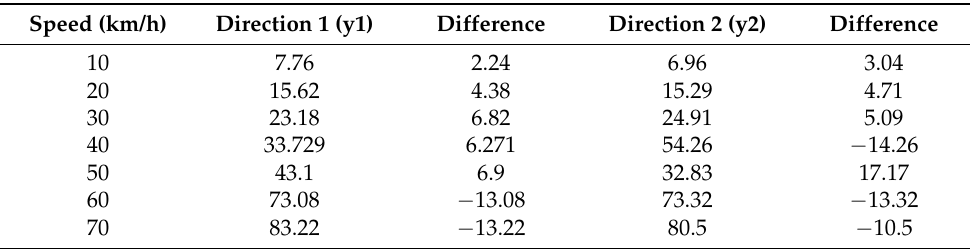
Table 6. The real car speed and detected speed with the proposed system over different car directions (Direction 1: near side and Direction 2: faraway side).